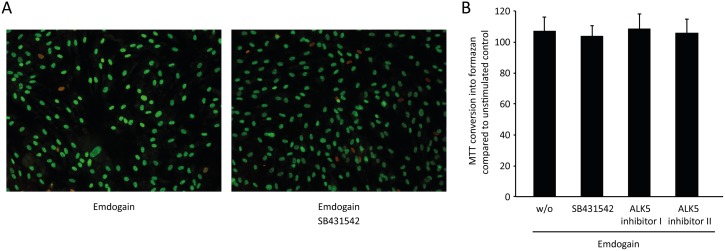
Viability is maintained when cells are exposed to TGF-β receptor I kinase inhibitors.Palatal fibroblasts were incubated with 100 µg/ml Emdogain or serum-free medium alone and the TGF-βRI kinase inhibitors SB431542, ALK5 Inhibitor I or ALK5 Inhibitor II. (A) MTT conversion assay shows that the presence of the three TGF-βRI kinase inhibitors had no significant impact on cell viability. (B) The nuclear-ID Red/Green cell viability assay confirms this finding as the distribution of viable green and dead red cells is not affected by SB431542. Experiments were performed three times.